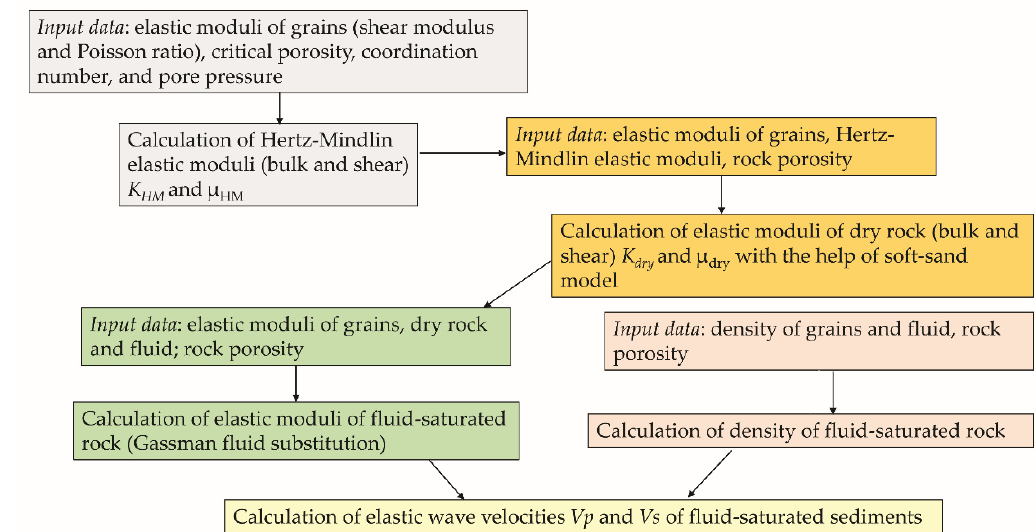
Figure A2. Flowchart for the determination of elastic wave velocities from the model parameters. A flowchart for the inverse problem—determination of the pore pressure from seismic data is shown in Figure A3.